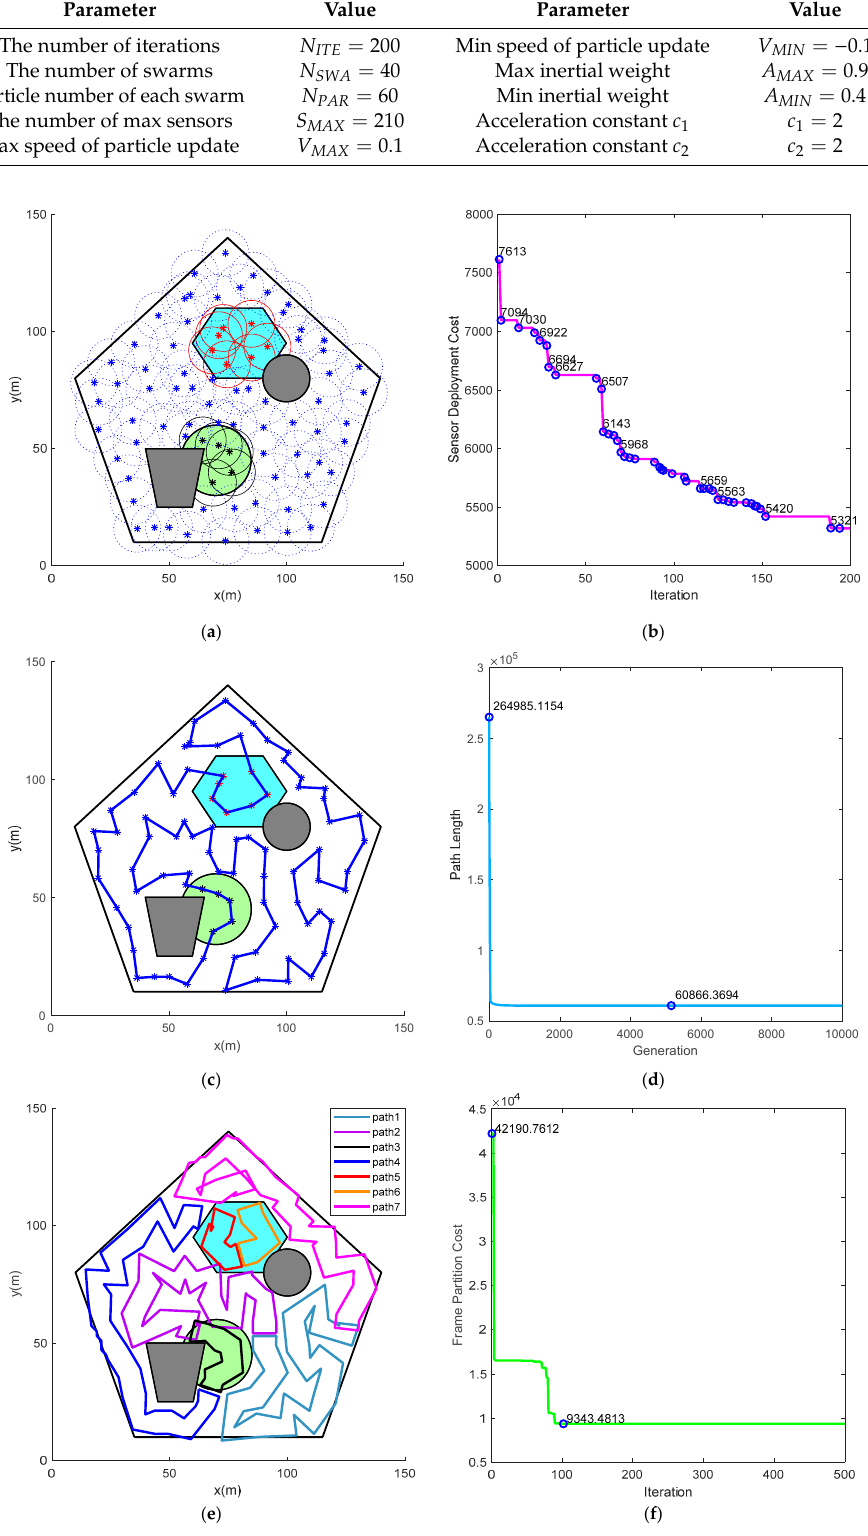
Figure 16. Simulation results under parameters in Tables 7 and 8. ( a ) Sensor deployment for complete coverage; ( b ) Sensor deployment cost; ( c ) Path planning result; ( d ) The changing process of path length; ( e ) The closed route for each robot; ( f ) Frame partition